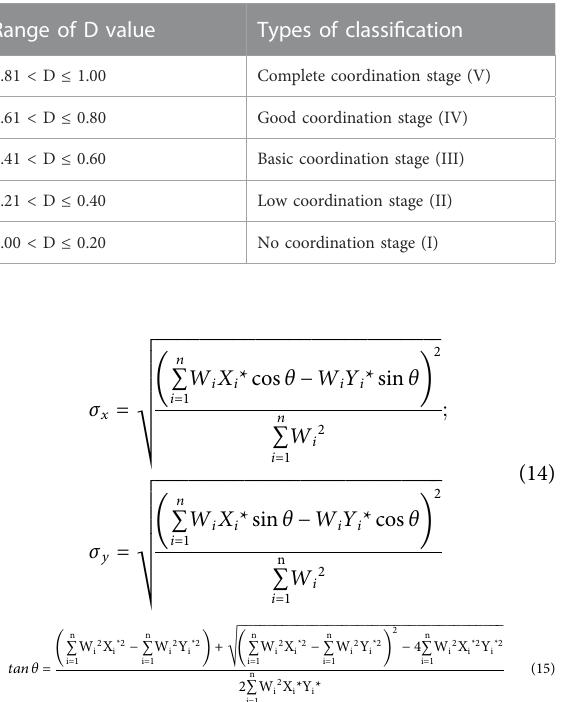
TABLE 2 Classi fi cation of coupling coordination